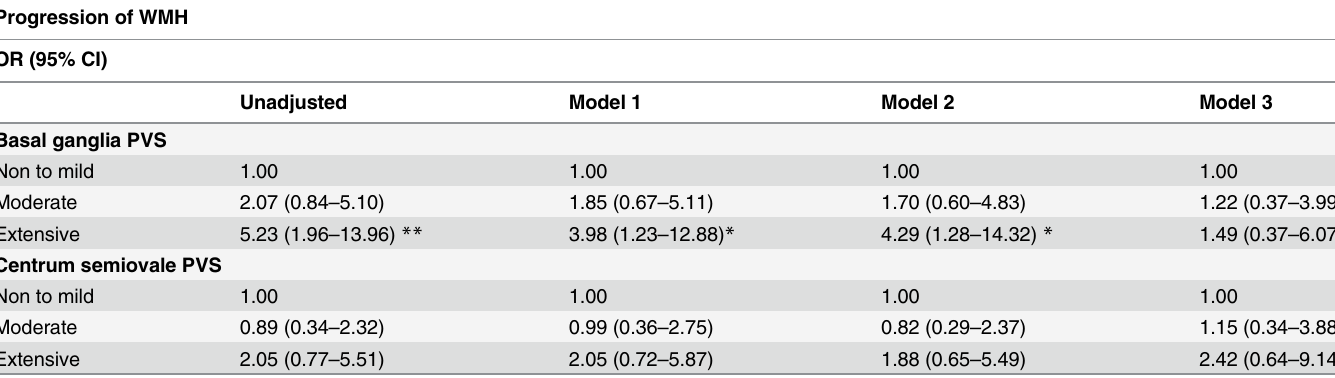
Table 3. Association between baseline PVS and progression of WMH by binary logistic regression analysis.